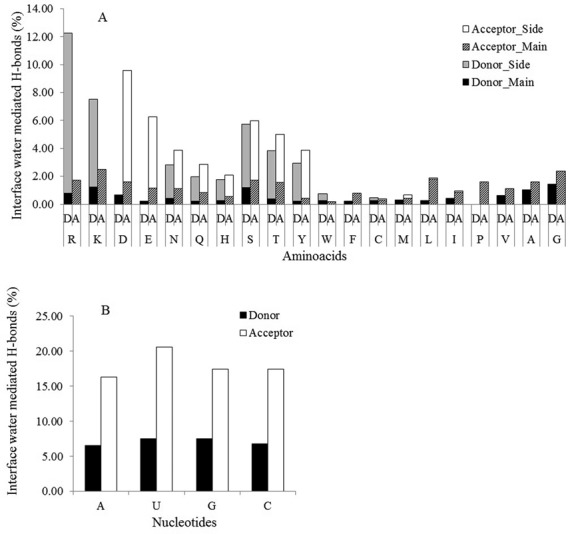
Percentage contribution of (A) amino acid residues, and (B) nucleotide bases to the interface water-mediated H-bonds. One-letter codes of the amino acid residues along with their contribution as the donor (D) or as the acceptor (A) are given along the abscissa in (A). One-letter codes of the nucleotide bases and their contribution as the donor (D) or as the acceptor (A) are given along the abscissa in (B).